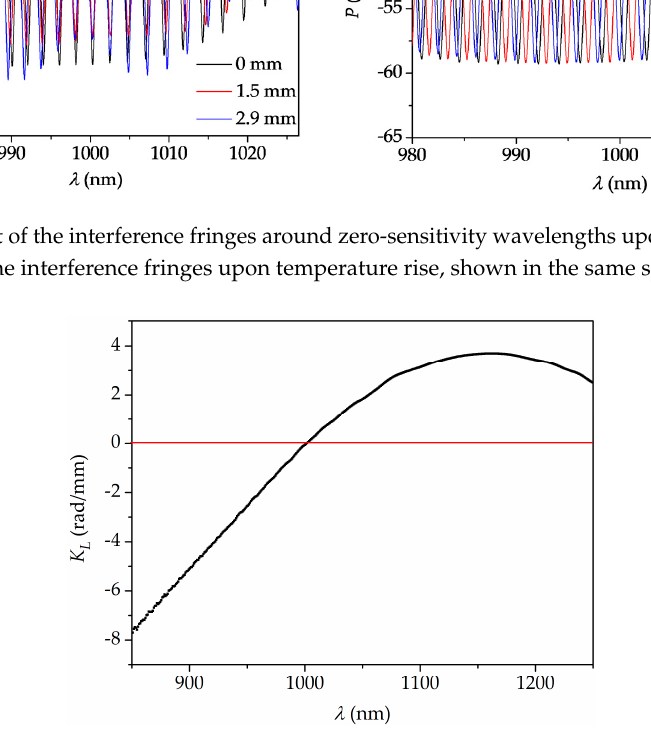
Figure 5. Spectral sensitivity to elongation K L (black points) measured for the TCF elongation of 2.9 mm (10 m ε ). The red line indicates zero level.